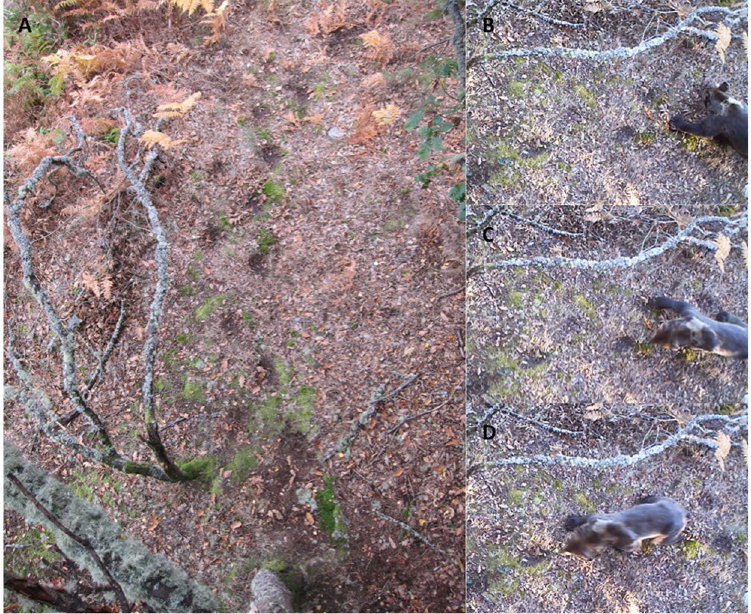
Figure 3. Snapshot from the camera in the studied marking site with visible depressions from previous pedal marking ( A) and a brown bear individual stretching to match the marks ( B – D ).